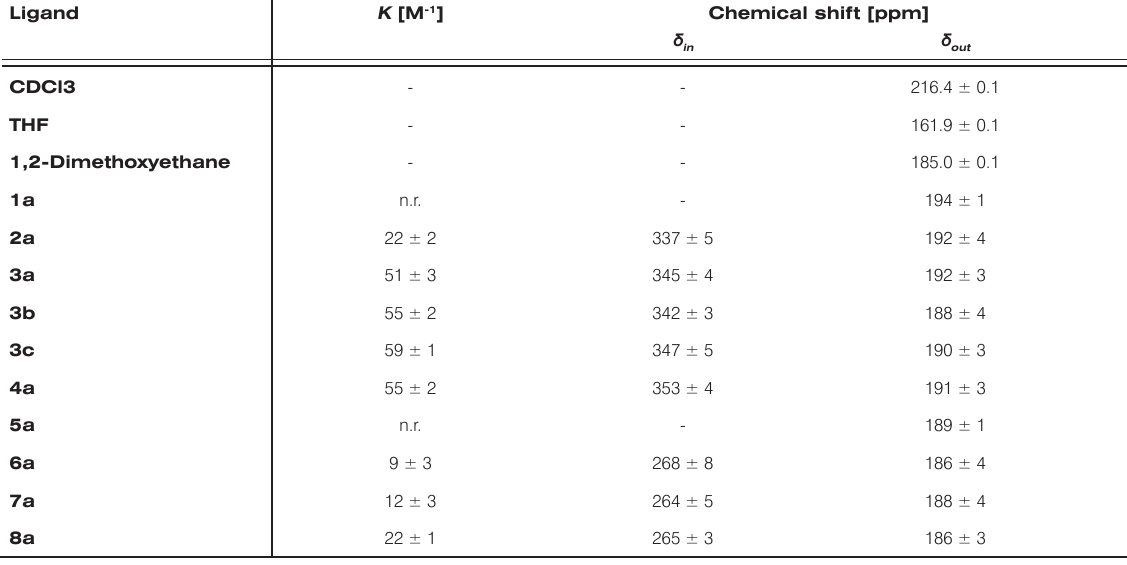
Table 1. Results of the 129 Xe NMR titration experiments for alkoxysilane ligands and solvents used. Ligand